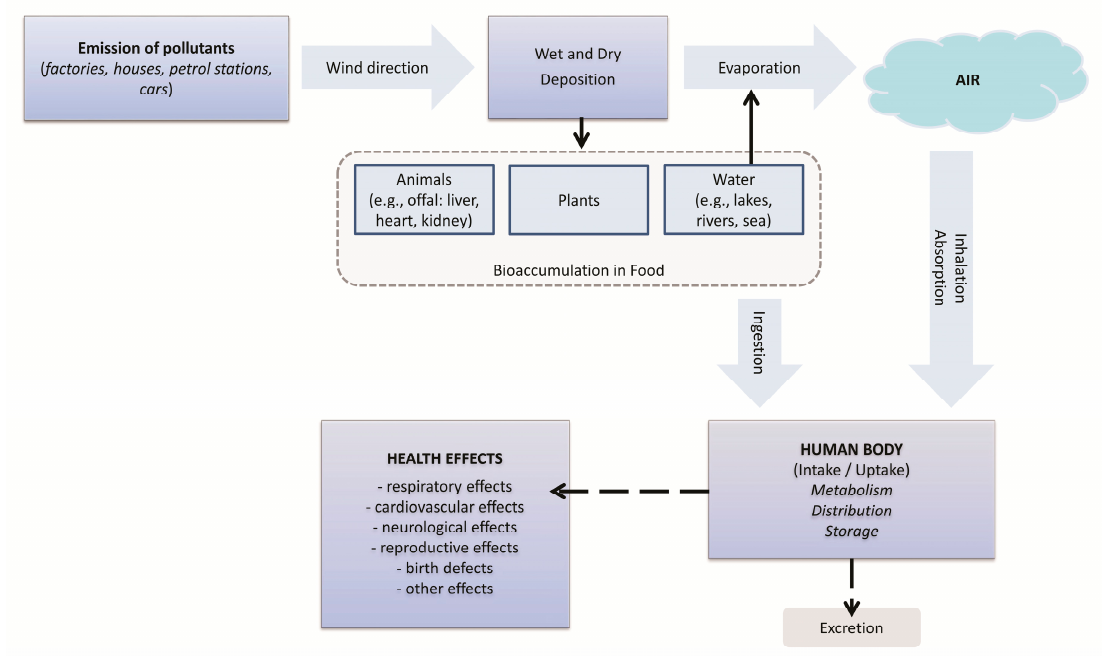
ff ects in humans (Adopted from: